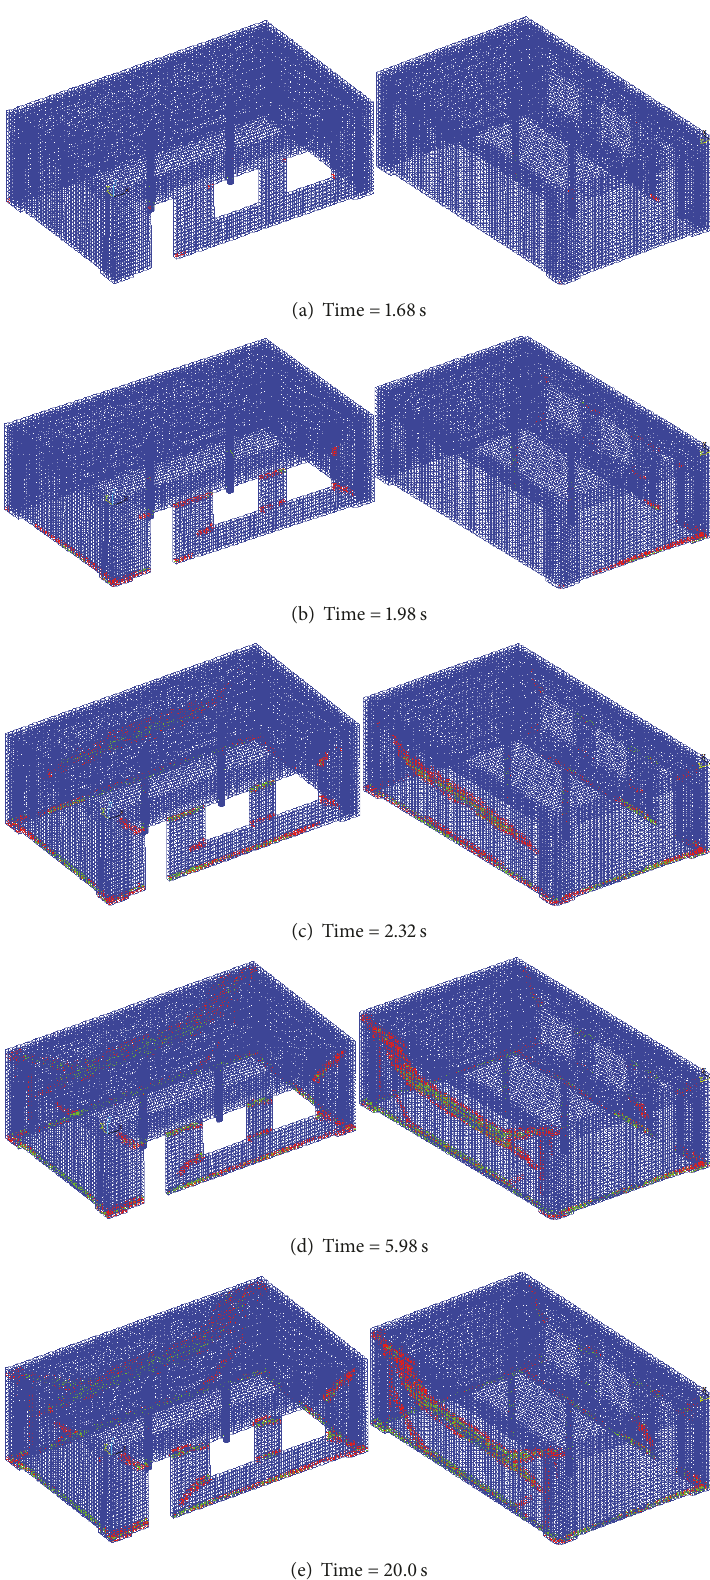
Figure 13: Crack distributions of the reinforced masonry structure at different